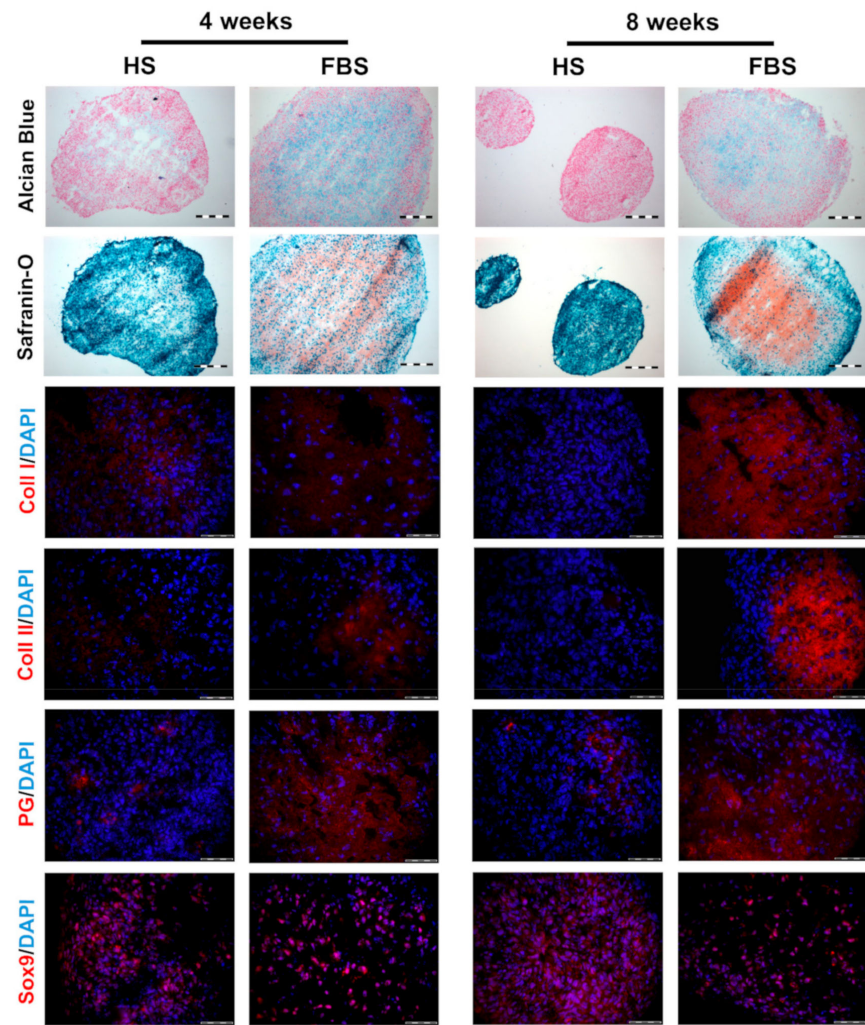
Figure 6. Comparison of the di ff erentiation degree of microtissues from one representative donor after 4 and 8 weeks of cultivation using cryosections. (Upper rows) Histological analyses visualizing glycosaminoglycans (Alcian Blue: Blue, Safranin O: Red) and cell nuclei (Alcian Blue: Pink, Safranin O: Cyan). Scale bars: 200 µ m. (Lower rows) Immunohistochemical analyses of cartilage-specific markers. Red: Collagen type I (Coll I), collagen type II (Coll II), proteoglycans (PG), and Sox9, respectively. Blue: Cell nuclei. Scale bars: 50 µ